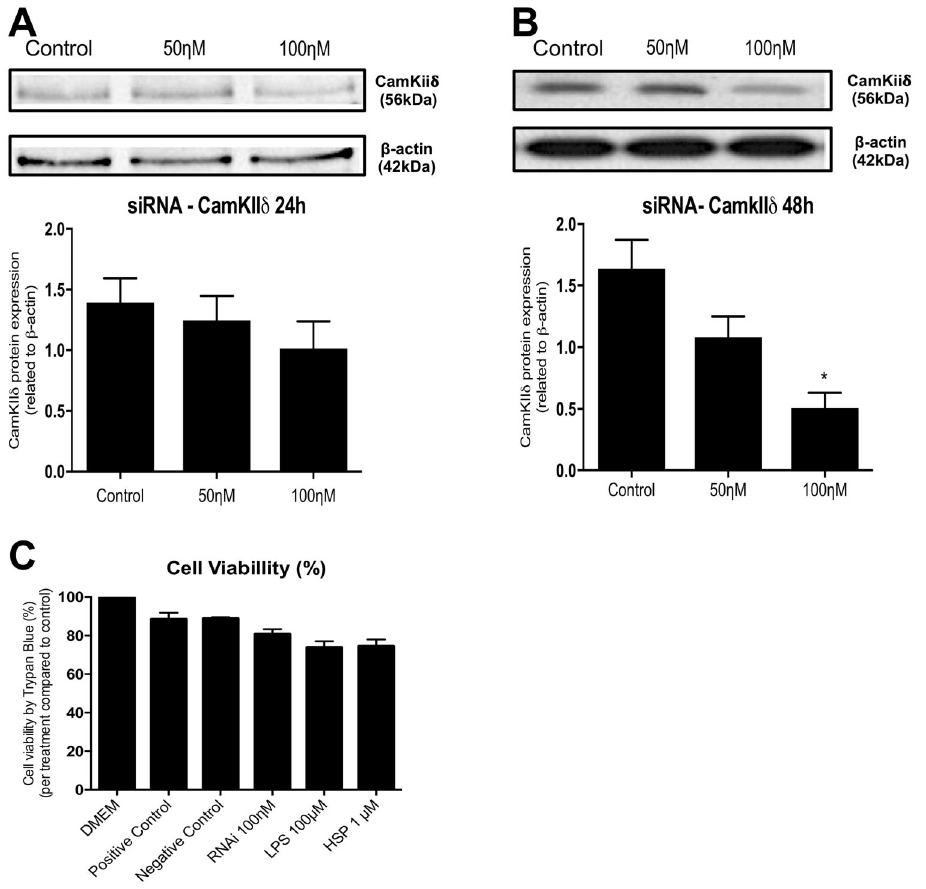
Figure 2. Silencing of CamKII and its effects on cellular viability. A , Representative images of western-blotting and protein expression of the silenced protein CamKII d in cardiomyocytes treated with 0.05 and 0.1 m M of siRNA for 24 h and B , for 48 h. C , Cellular viability after treatments compared to control/RNAi control cells. Data are reported as means ± SE. *P o 0.05 vs Control (n=4 in all experimental groups;